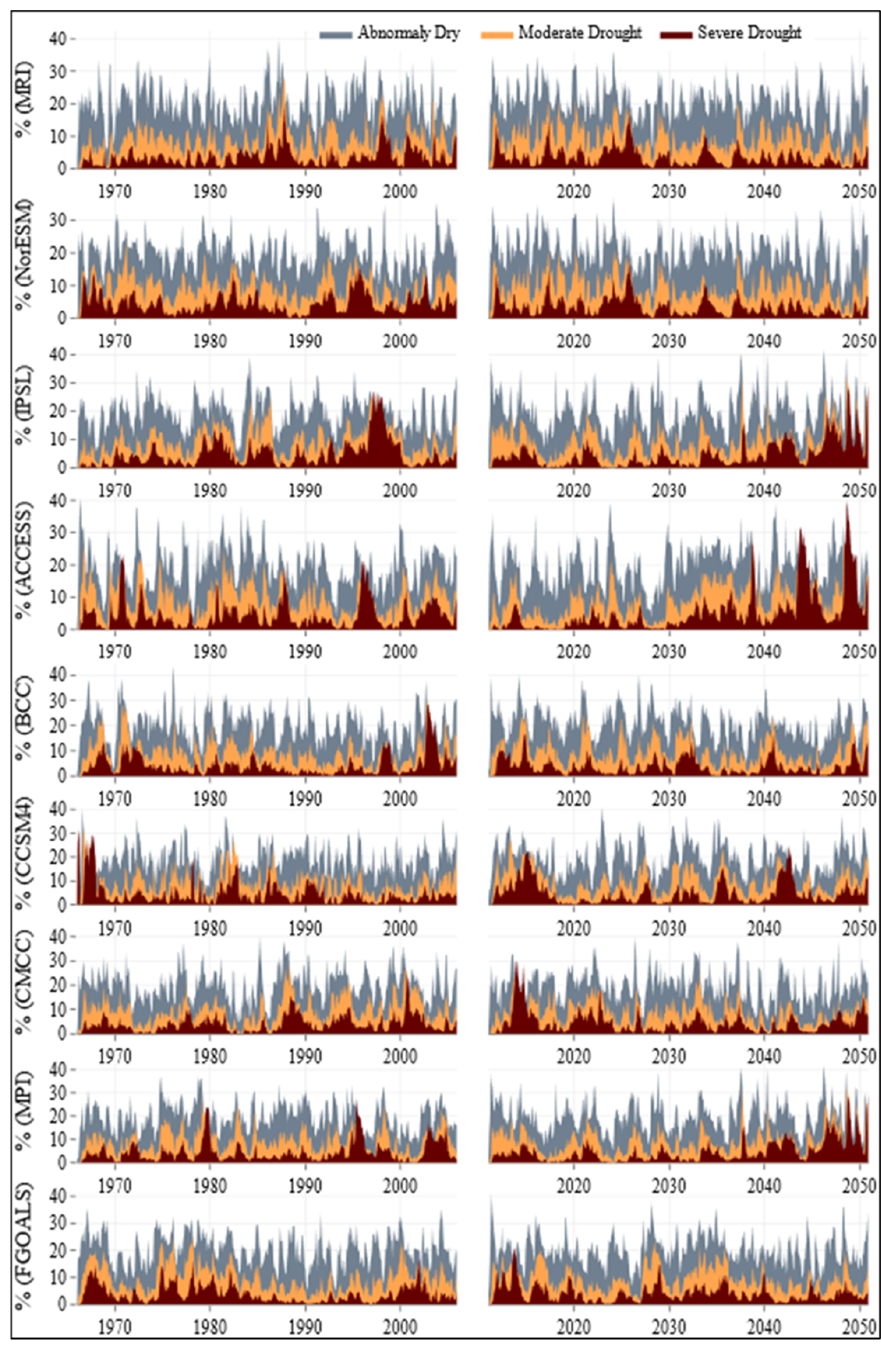
Figure 2. Proportion of conterminous USA land area under drought. The left panel represents the historical period, and the right panel represents the future period.